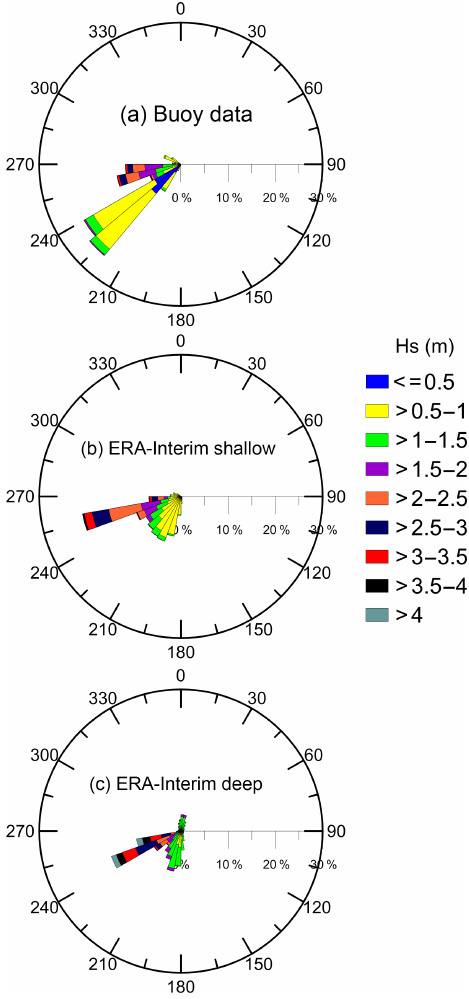
Figure 12. Wave rose plots from March 2008 to February 2016 based on the measured buoy data and the ERA-Interim reanalysis data at shallow and deep water